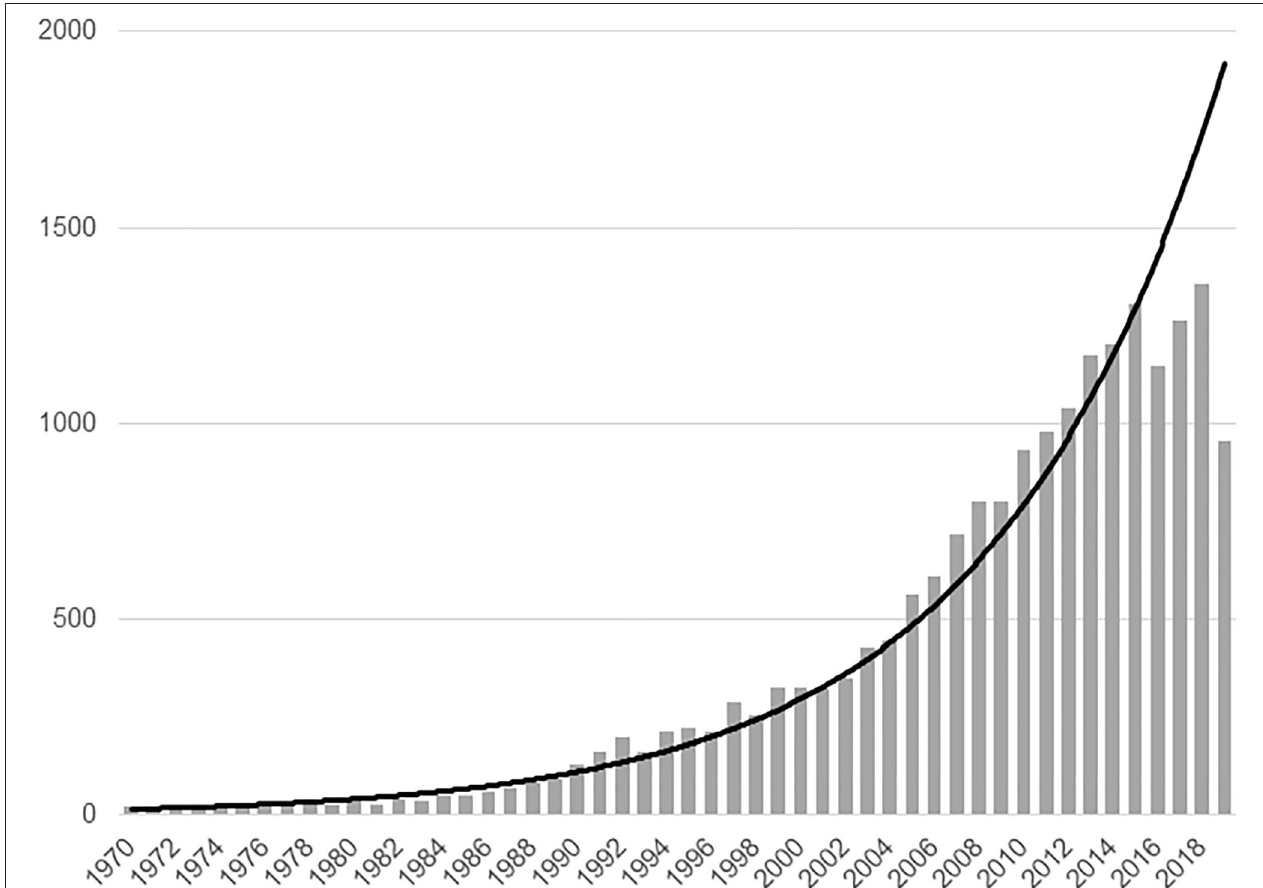
FIGURE 1 | Neuroimaging studies in schizophrenia spectrum disorders. A PubMed search was performed on 7/29/20 with the following search term: (Schizophrenia OR Schizoaffective disorder OR Schizophreniform disorder OR Brief psychotic disorder OR Psychosis) AND (Neuroimaging OR PET OR SPECT OR MRI OR Diffusion OR Spectroscopy OR Connectivity). The search was restricted to studies published 1970 or later and to human